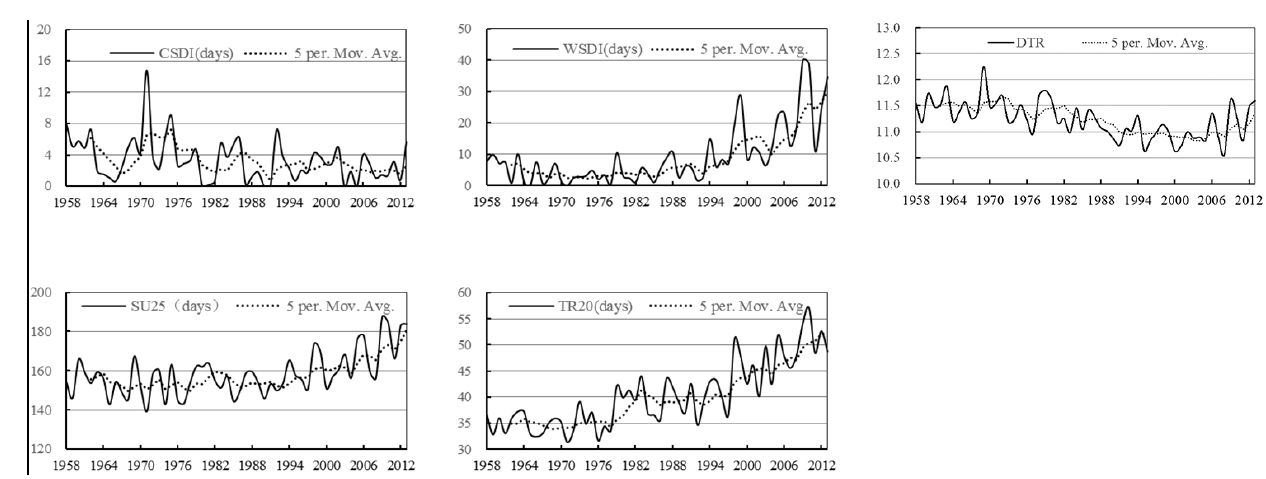
Figure 3. Trend of annual average extreme temperature indices (CSDI, WSDI, DTR, SU25 and TR20) in Yunnan Province from 1958 to 2013. (Dashed line is the 5-years moving